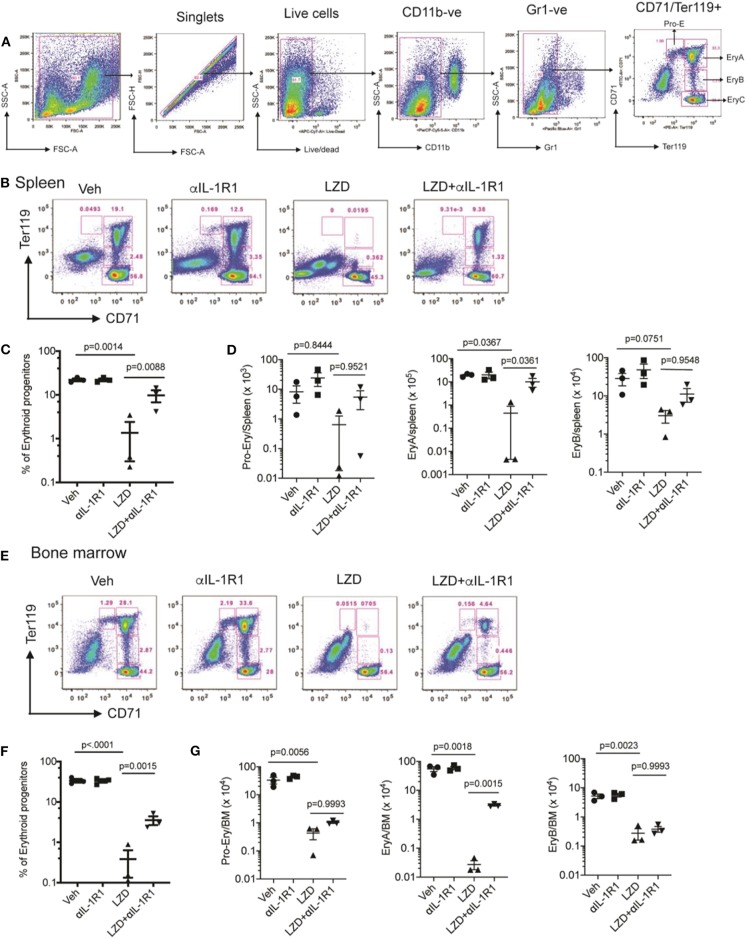
Erythropoiesis associated with LZD treatment was partially relieved after IL-1R1 blockade. C3HeB/FeJ mice were infected with Mtb Erdman for 4 weeks, and treated with LZD either alone or in combination with anti-IL-1R1 antibody for the subsequent 18 days. (A) Gating strategy for detecting erythroid progenitors is shown. Erythroid progenitors in the spleen (B–D) and bone marrow (E–G) were quantified by flow cytometry as described in Materials and Methods. Representative flow cytometry plots, percent, and total numbers of the early erythroid progenitors (sum of Pro-Ery, EryA, EryB) among different treatment groups are shown (C,F). Cell numbers in each subset are also shown (D,G). Data shown (Mean ± SD) are from two independent experiments. One-way ANOVA with Dunnett's post-test was applied to calculate the p-value by comparing the mean of each group with that of LZD treated group. N = 3–5 mice per group.